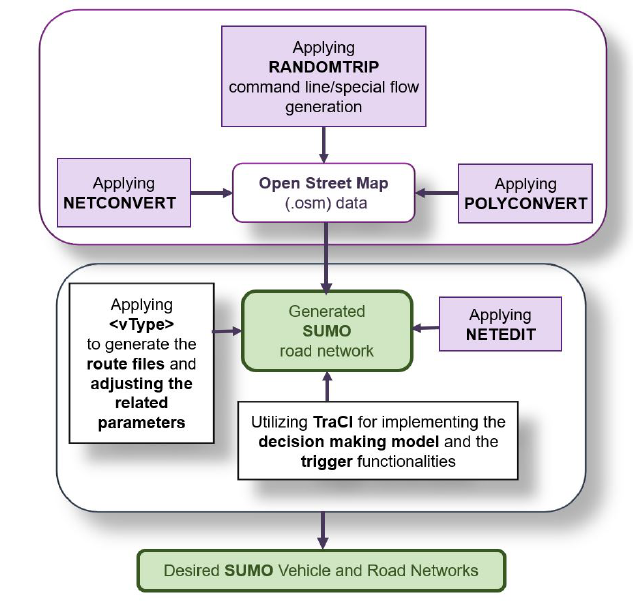
Figure 11. SUMO simulation steps (adapted from [35]).